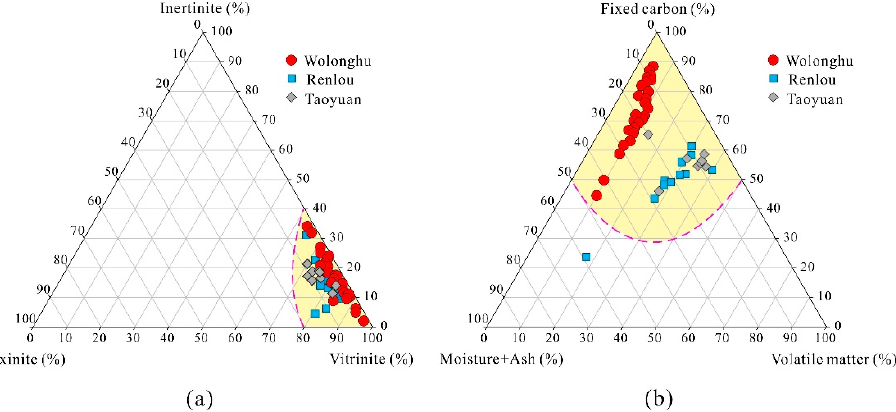
Figure 3. Maceral components ( a ) and chemical compositions ( b ) of the selected coal samples in the Huaibei Coalfield.